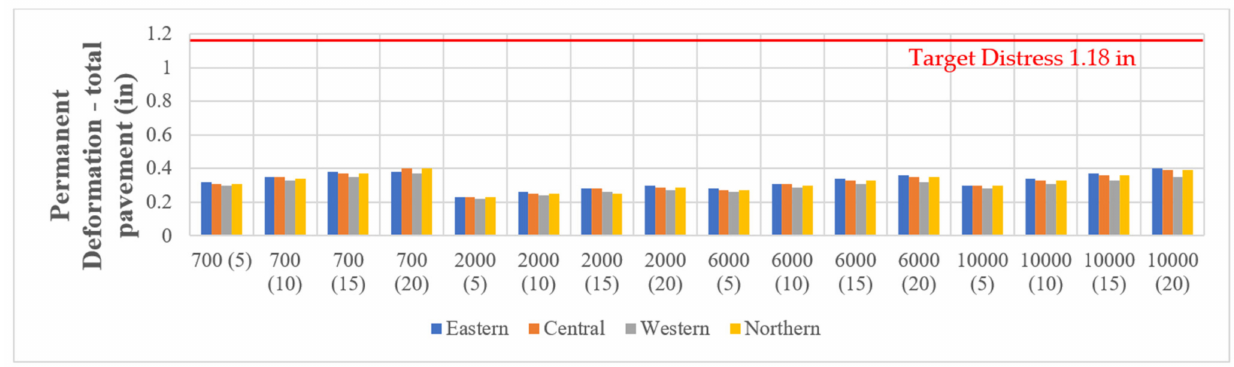
Figure 13. Permanent deformation—total pavement (in) for an interval of 5, 10, 15, and 20 years.